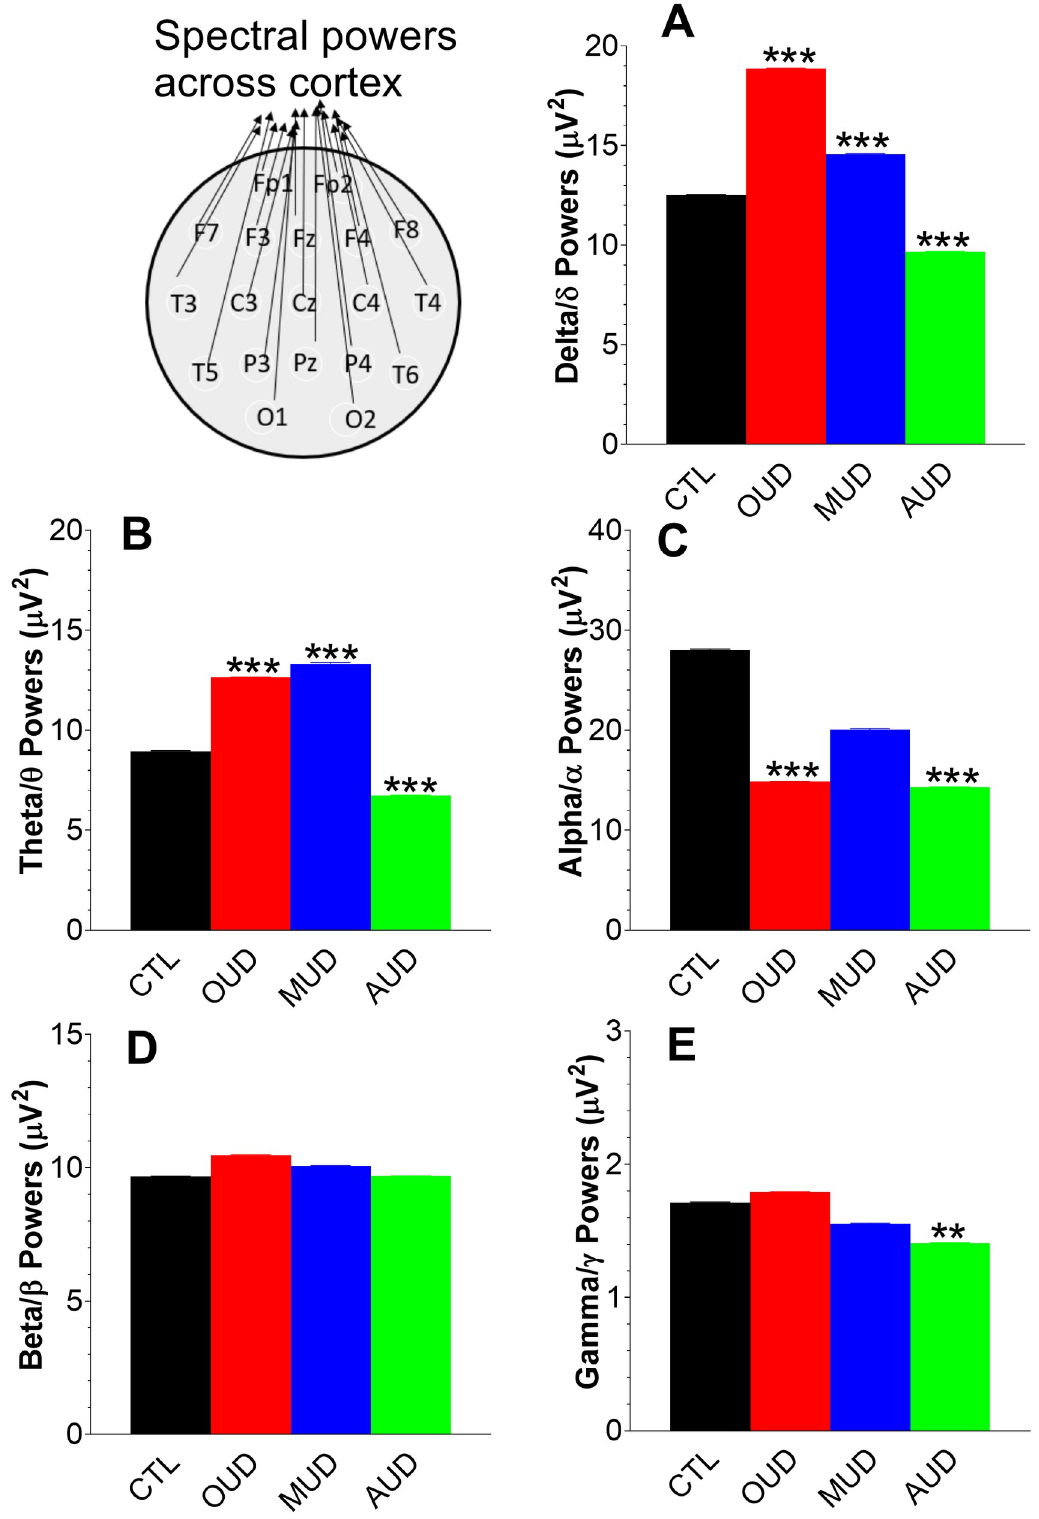
Fig 8. Analysis of spectral powers as a whole across cortex. Data are expressed as mean ± SEM. Compared to CTL, spectral powers in patients with SUD (OUD, MUD or AUD) were significantly altered in delta/ δ ( A ) and theta/ θ ( B ), partly alpha/ α ( C ) or gamma/ γ ( E ). No effect was observed in the beta/ β ( D ). �� P < 0.01, and ��� P < 0.001 vs . CTL, unpaired t-test. https://doi.org/10.1371/journal.pone.0248794.g008 PLOS ONE | https://doi.org/10.1371/journal.pone.0248794 September 10,